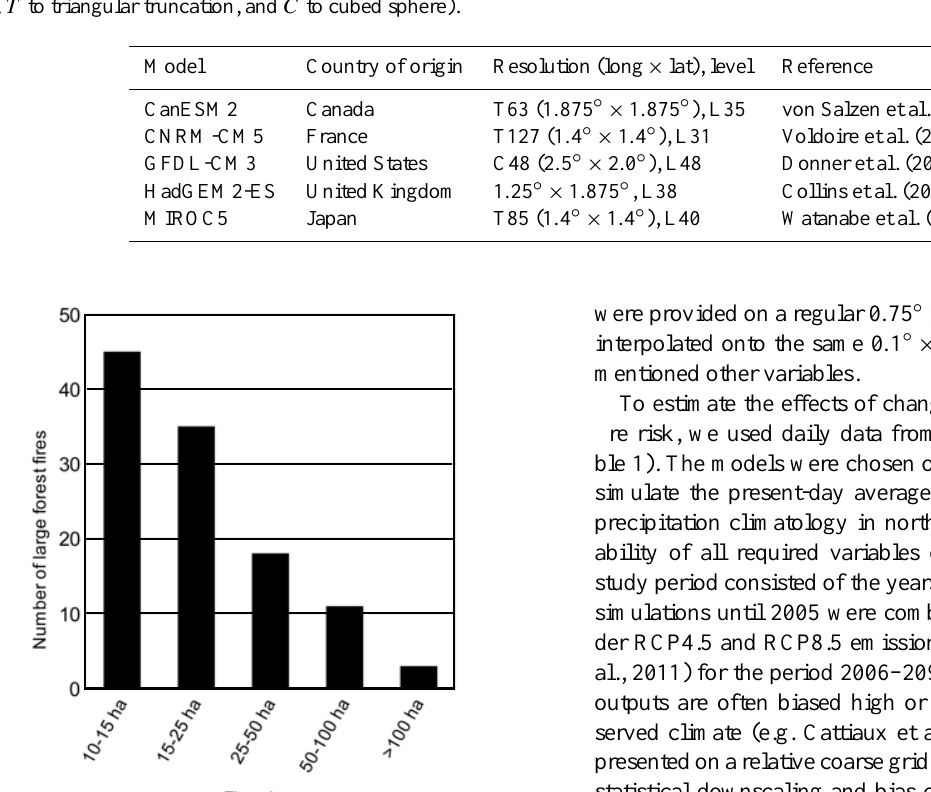
Table 1. CMIP5 models used in this study with information on country of origin and resolution of the models ( L refers to number of vertical levels, T to triangular truncation, and C to cubed sphere).